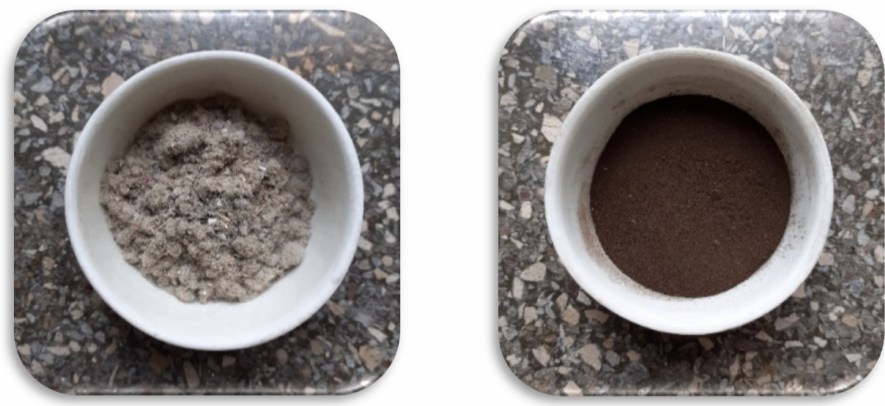
Figure 1. Under-sieve fraction of municipal mixed waste prior to and after hydrothermal carbonization.